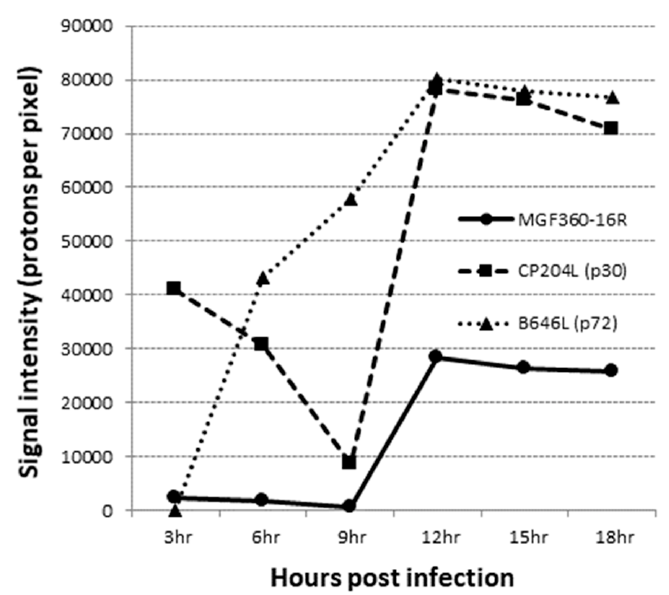
Figure 3. Time course of MGF360-16R gene transcriptional activity. Averaged microarray signal intensities (photons per pixel) of ASFV MGF360-16R, CP204L, and B646L open reading frame RNA prepared from ex vivo pig macrophages infected with ASFV at 3, 6, 9, 12, 15, and 18 h post